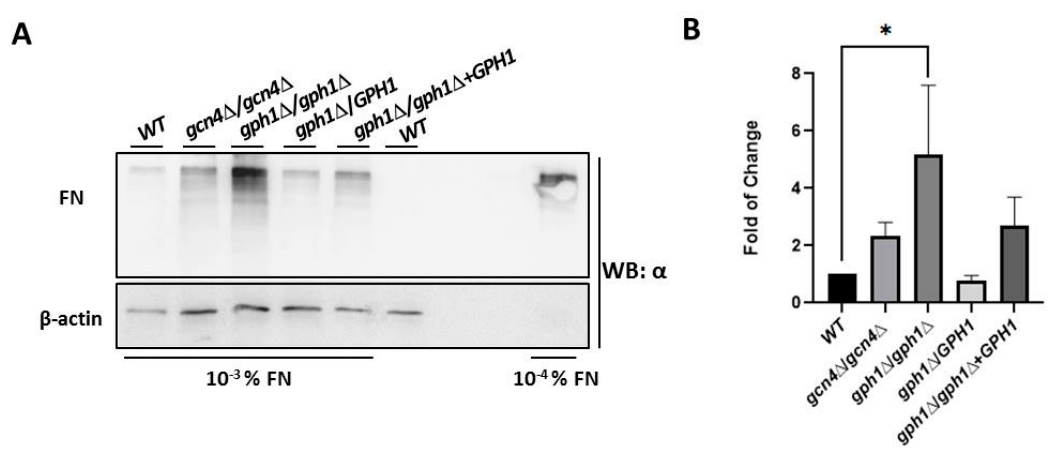
Figure 5. GPH1 negatively regulates binding with fibronectin (FN) in C. albicans . Western blots for FN after pre-treatment of C. albicans cells with 10 − 3 % fibronectin for 1 h, as described in the Materials and Methods. The GCN4 null mutant gcn4 Δ / gcn4 Δ , known to reduce biofilm formation, was included in the assay. The fibronectin was detected by the antibody specific to fibronectin. The 10 − 4 % fibronectin was used as a control. The β -actin was used as a loading control and was detected by an anti- β -actin antibody. ( A ) The represented Western blot. ( B ) The fold of change in association with fibronectin in comparison with the wild-type strain SC5314 (WT). Statistical analyses were performed by one-way ANOVA, with * p < 0.05 as indicated.